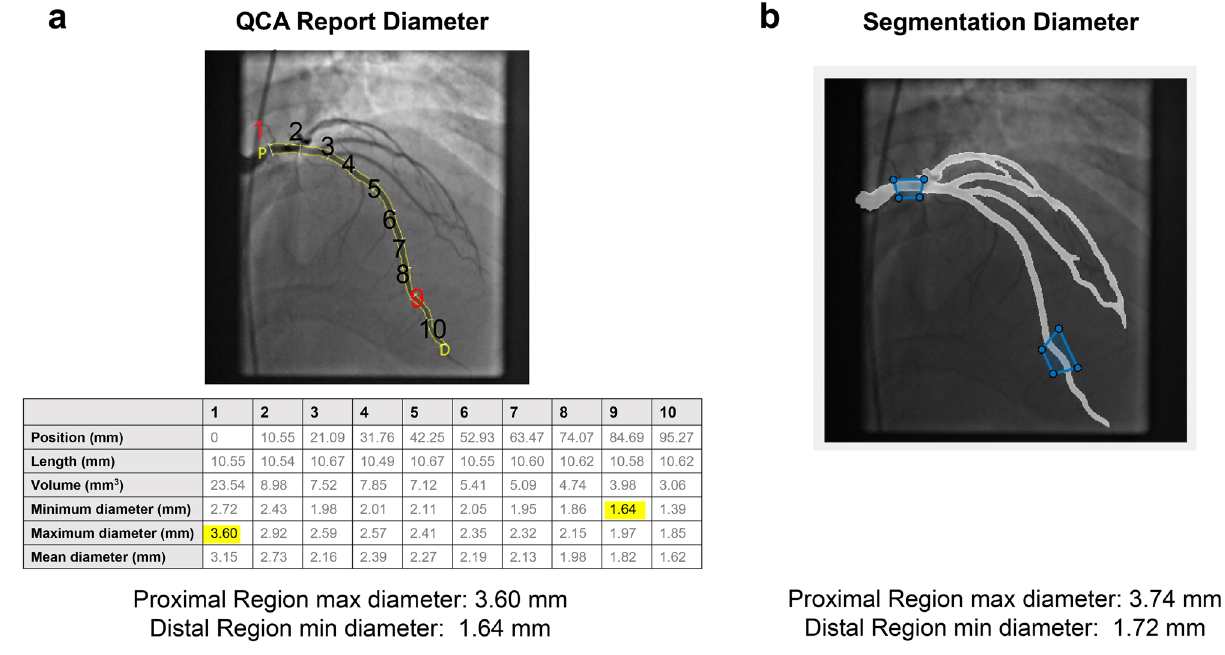
Figure 2. ( a ) Annotated QCA report, along with the corresponding diameters in the report table. Highlighted values correspond to maximum (proximal) and minimum (distal) diameters (segments 1 and 9, respectively). ( b ) Schematic of how a MATLAB script was used to delineate regions in the neural network segmentation corresponding to the regions measured in the QCA report, along with the computed proximal and distal